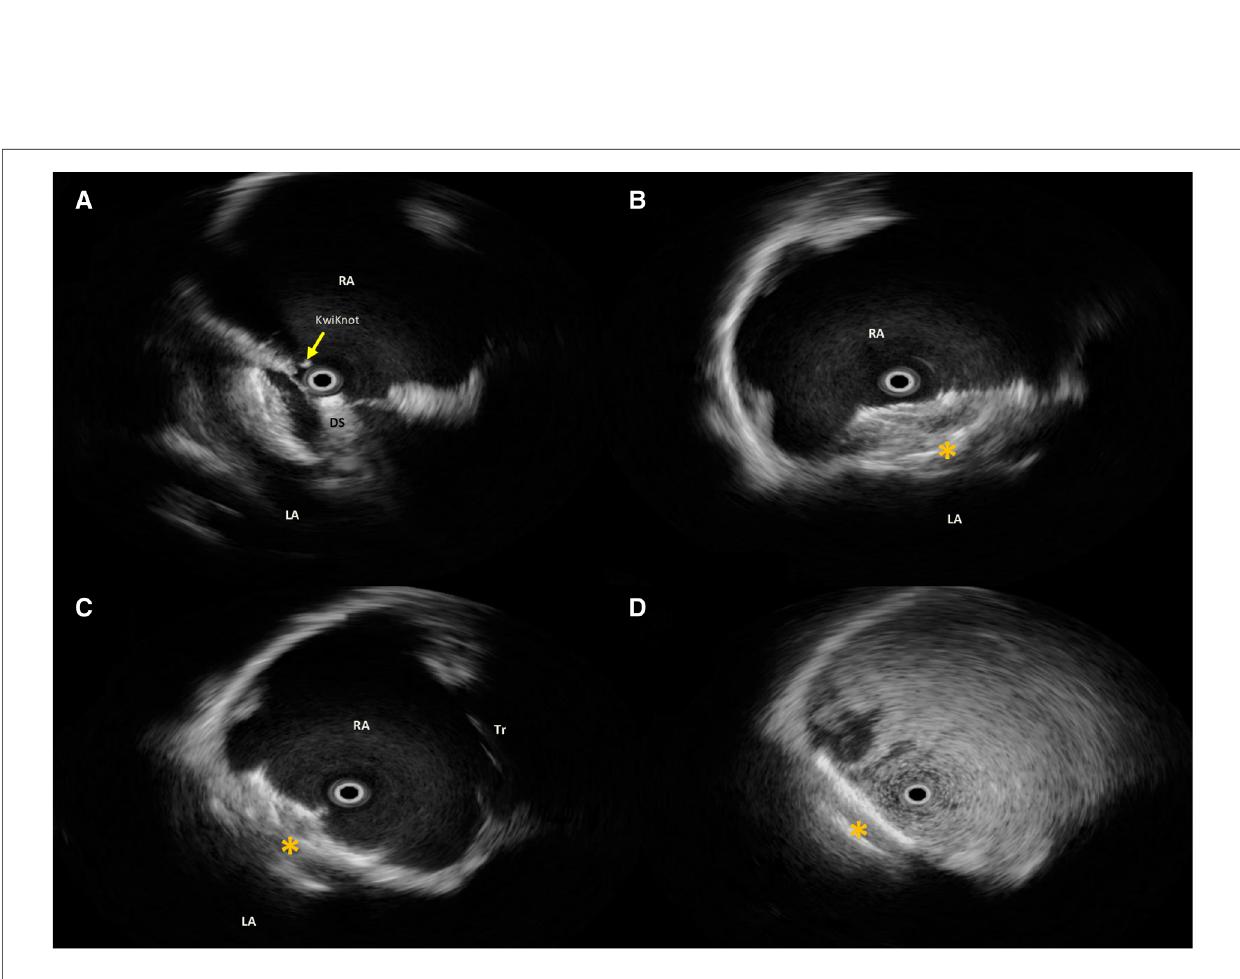
FIGURE 2 Intraprocedural rotational intracardiac Echo by Ultra ICE (mechanical 9F/9 MHz 360° scan probe, Ultra ICE TM , EP technologies, BSC, CA, United States) in the parasagittal long axis ( “ four chamber ” ) plane showing procedural steps ( A – C ) of implantation of Flex II UNI occluder (Occlutech GmbH, Jena, Germany) with equally sized discs (28.5 mm×28.5 mm) (orange asterisk); ( D ) after agitated saline solution injection from the femoral vein, no residual shunt immediately after device release. RA, right atrium; LA, left atrium; DS, delivery sheath across the septal fenestration.